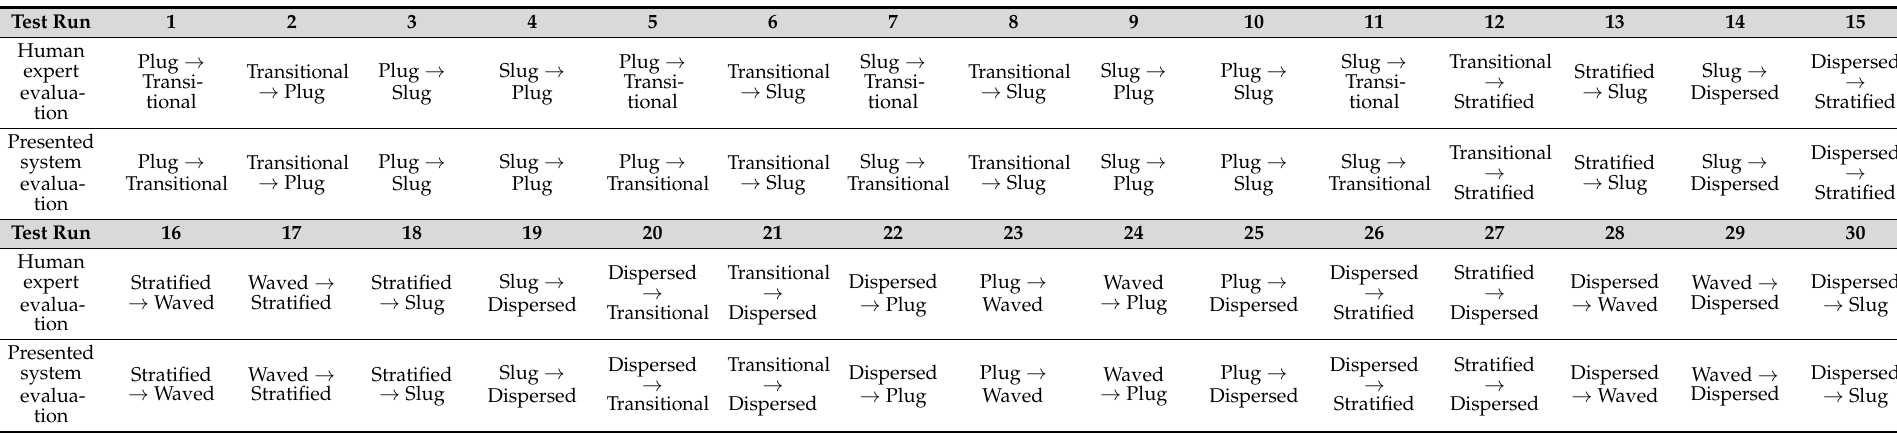
Table 1. Report of the results of the test for control